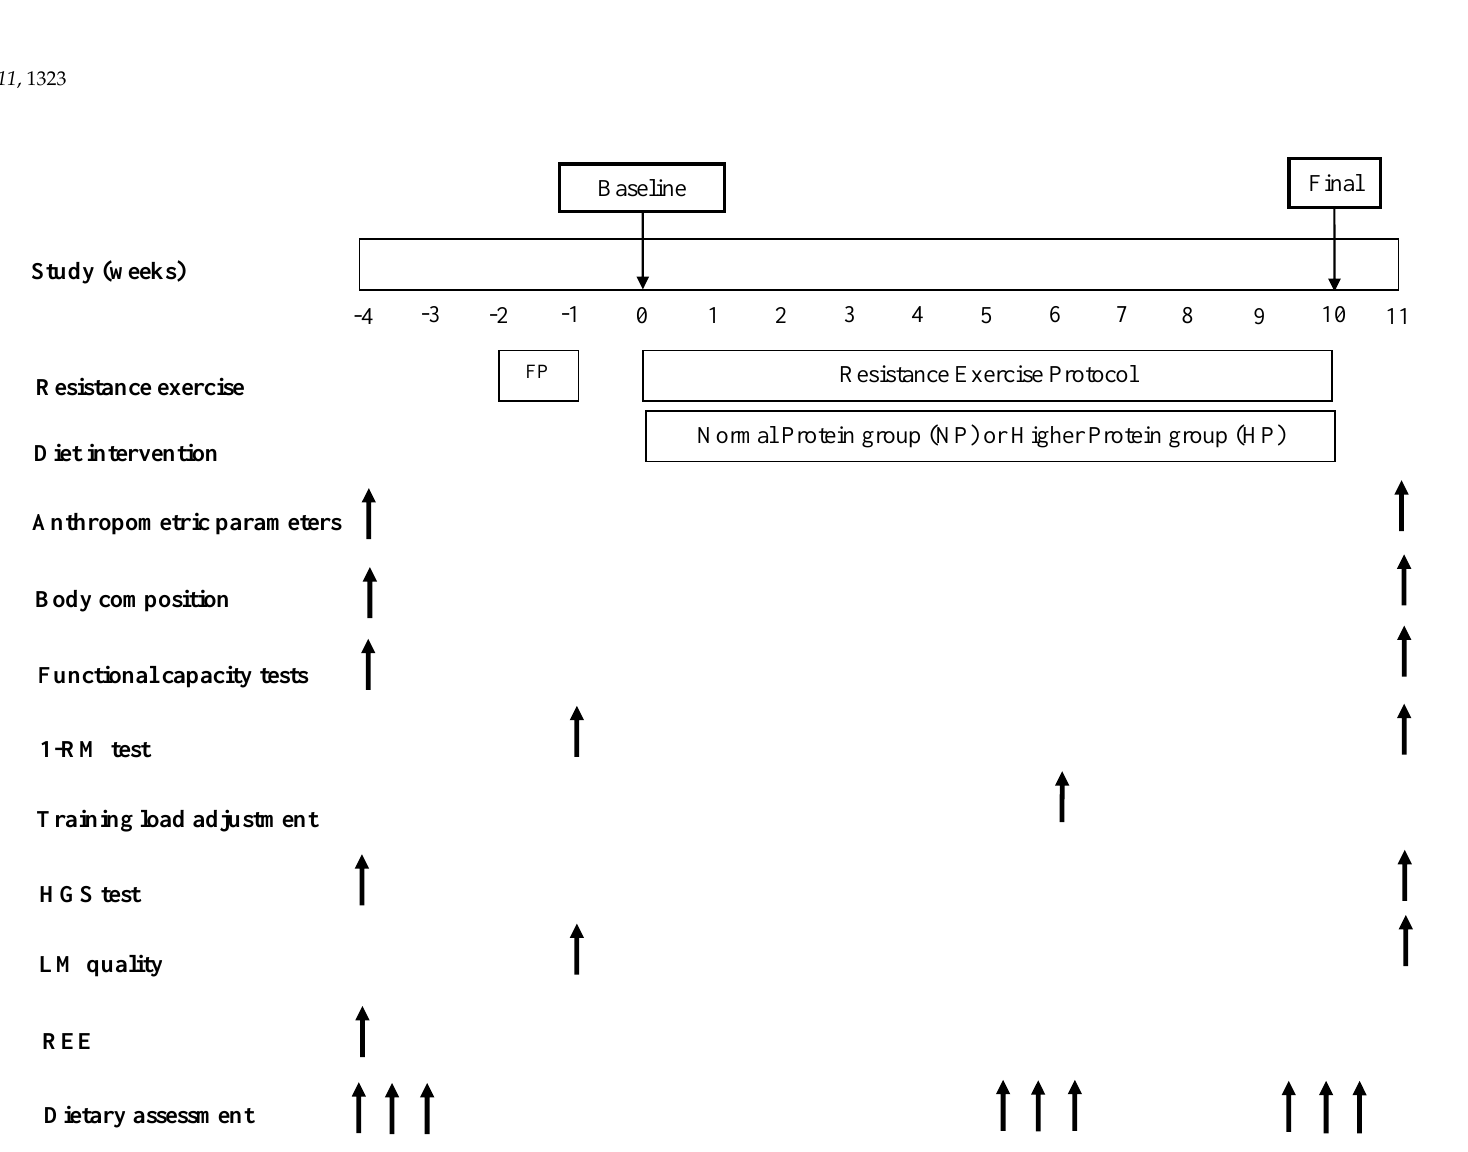
Figure 2. Schematic overview of the study design. Notes: FP, familiarization period; 1-RM, one maximum repetition test; HGS, handgrip strength; LM, lean mass; REE, Resting Energy